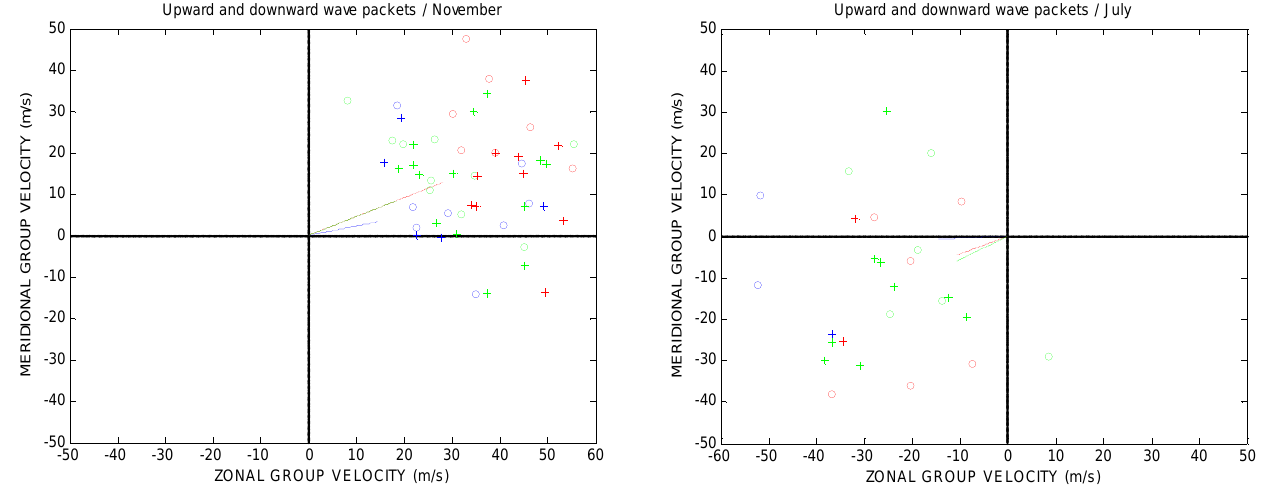
Fig. 6a. Plot of meridional group velocity vs. zonal group velo- city of virtual gravity wave packets in the month of November. “o” Fig.6a Plot of meridional group velocity .vs. zonal group velocity of virtual gravity stands for upward, while “ + ” for downward propagating virtual wave packets in the month of November. ‘o’ stand for upward, while ‘+’ for 900 gravity wave packets; blue denotes 1986; red denotes 1988; and downward propagating virtual gravity wave packets; Blue color denoted the year of green denotes 1989. Colored lines represent the respective mean wind velocities. 1986; red color denoted the year of 1988; and green color denoted the year of 1989. Colored straights lines represent the respective mean wind velocities.